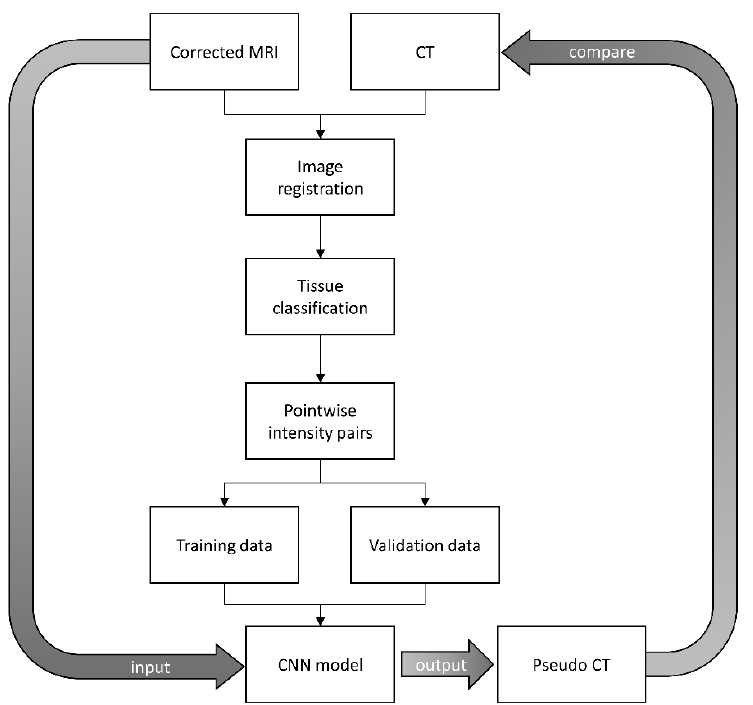
Figure 3. The processing steps of CNN model training and validation to convert corrected MRI into pseudo-CT.